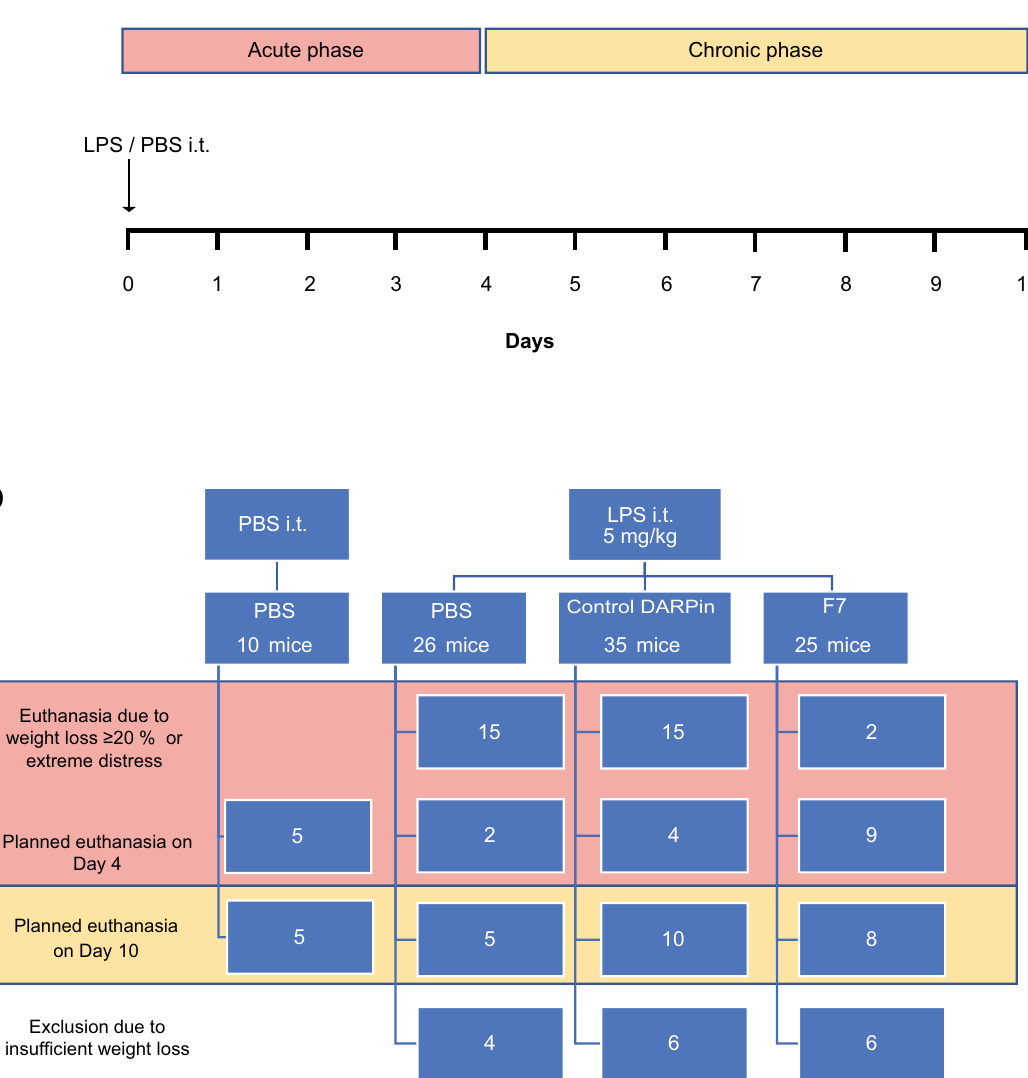
DARPin F7 protects from a systemic inflammatory reaction in peripheral blood. As expected, the percentage of neutrophils (CD45 + CD11b + Ly6C + Ly6G + ) in blood was significantly increased in the group treated with PBS or the control DARPin. This effect was significantly reduced in the F7 and the healthy control group (percentage of neutrophils PBS vs. control DARPin vs. F7 vs. healthy controls: 49.9 ± 4.35 vs. 42.6 ± 3.69 vs. 25.9 ± 2.45 vs. 15.7 ± 8.54, p < 0.001 F7 vs. PBS, p = 0.002 F7 vs. control DARPin, Fig. 3). The percentage of monocytes (CD45 + CD11b + Ly6C + Ly6G - ) in the peripheral blood was less affected since healthy control mice, mice treated with the control DARPin and F7 did not significantly differ. A significantly reduced percentage of